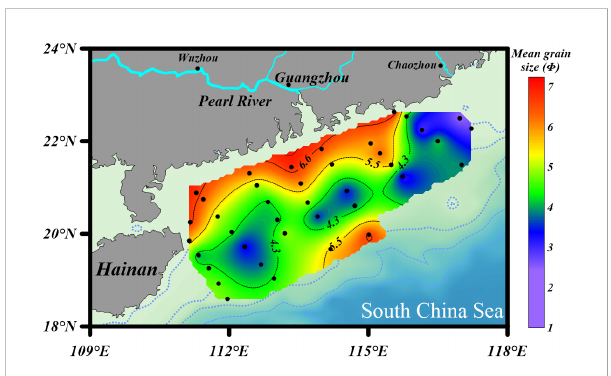
FIGURE 5 Distribution of bSiO 2 /OC molar ratio in surface sediments of the